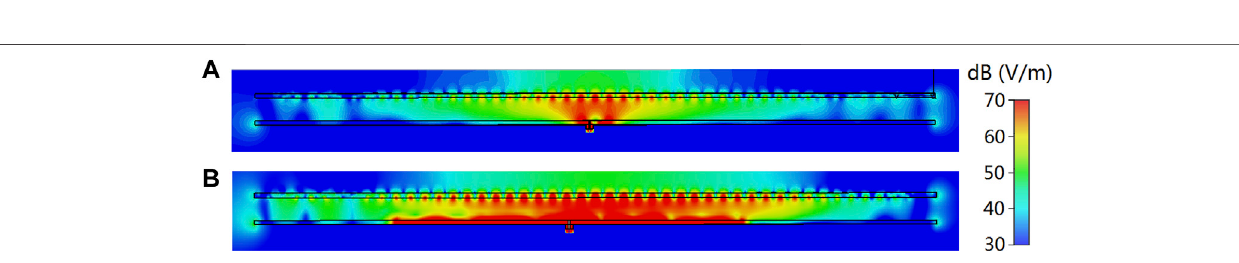
FIGURE 7 | Performance of the radiation source. (A) Simulated gain of the H-plane. (B) Simulated gain of the E-plane.